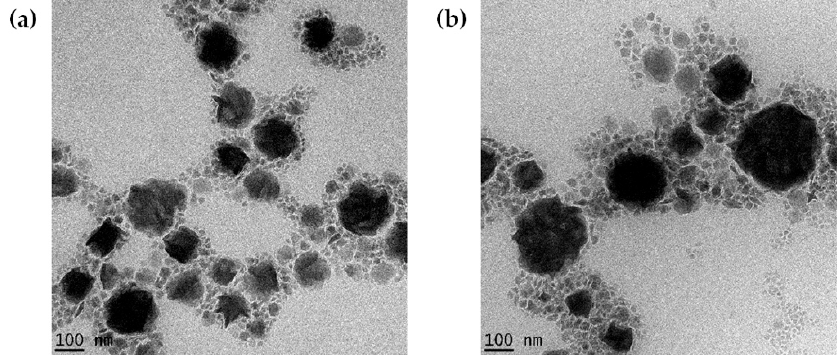
Figure 3. Transmission electron microscopy (TEM) images of nanostructured lipid carriers (NLC) prepared by high-shear homogenization (HSH) with high shear intensity; ( a ) blank NLC and ( b ) chili-extract-loaded NLC.